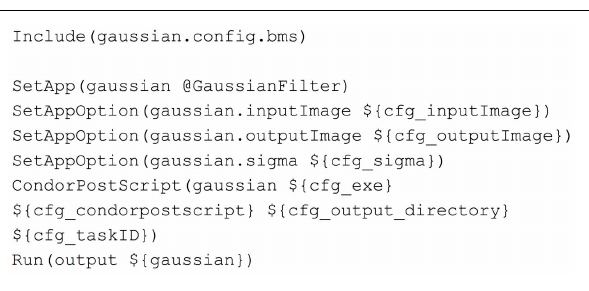
FIGURE 3 | Gaussian.config.bms.